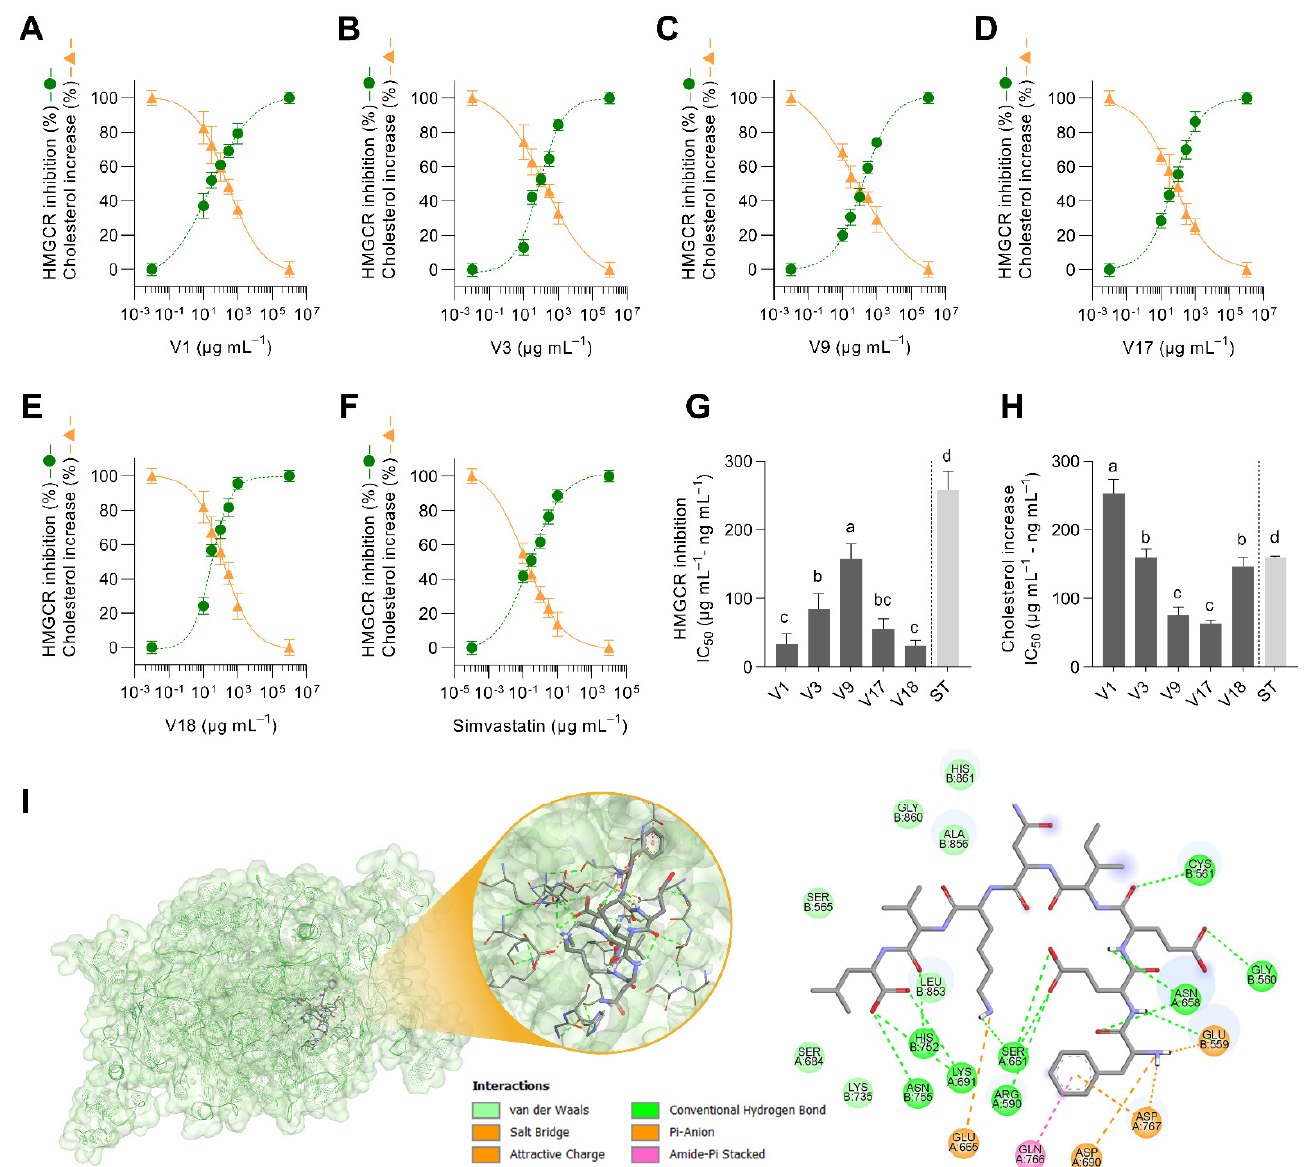
Figure 5. Dose–response curves of the effect of selected soybean digested varieties ( A – E ) and simvastatin (ST) ( F ) on the 3-hydroxy-3-methylglutaryl-CoA reductase (HMGCR) activity and cholesterol concentration increase in free fatty acid-stimulated HepG2 liver cells (500 µ mol L − 1 oleic: palmitic acid, 2:1) and their half-inhibitory concentration (IC 50 , µ g protein mL − 1 ; ng simvastatin mL − 1 ) on HMGCR activity ( G ) and cholesterol concentration increase ( H ). Representative HMGCR-peptide (FEEINKVL) in silico interaction in the active site ( I ). Results are reported as mean ± SD ( n =